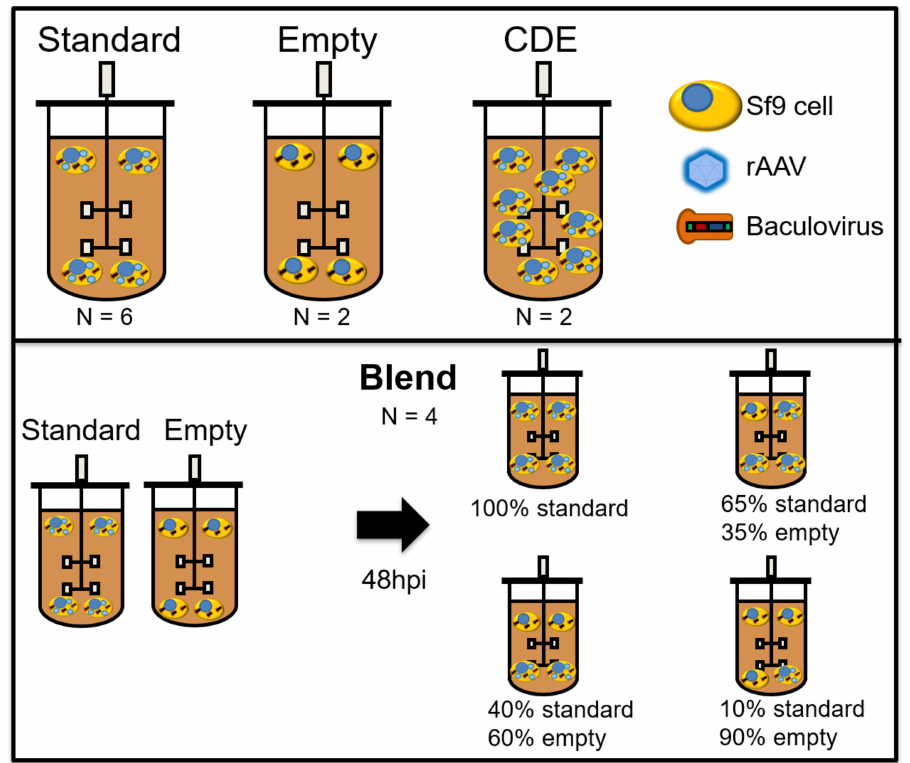
Figure 1. Overview of the di ff erent batches used for model calibration. “Standard” runs represent a normal infection process, with coinfection with Rep / Cap and transgene-BIICs (baculovirus-infected insect cells). “Empty” runs were infected with an empty-BIIC, a BIIC which was infected with a baculovirus vector devoid of any transgene, but still able to replicate and induce cytopathic e ff ects in infected cells. Cell density e ff ect (CDE) runs are like “standard” runs, except that infection was performed at 5 × 10 6 cells / mL instead of 3 × 10 6 . “Blend” runs started with separate “standard” and “empty” batches. Two days after infection, cells from both reactors were transferred to new bioreactors, with the indicated proportions of each batch. Hpi—hours